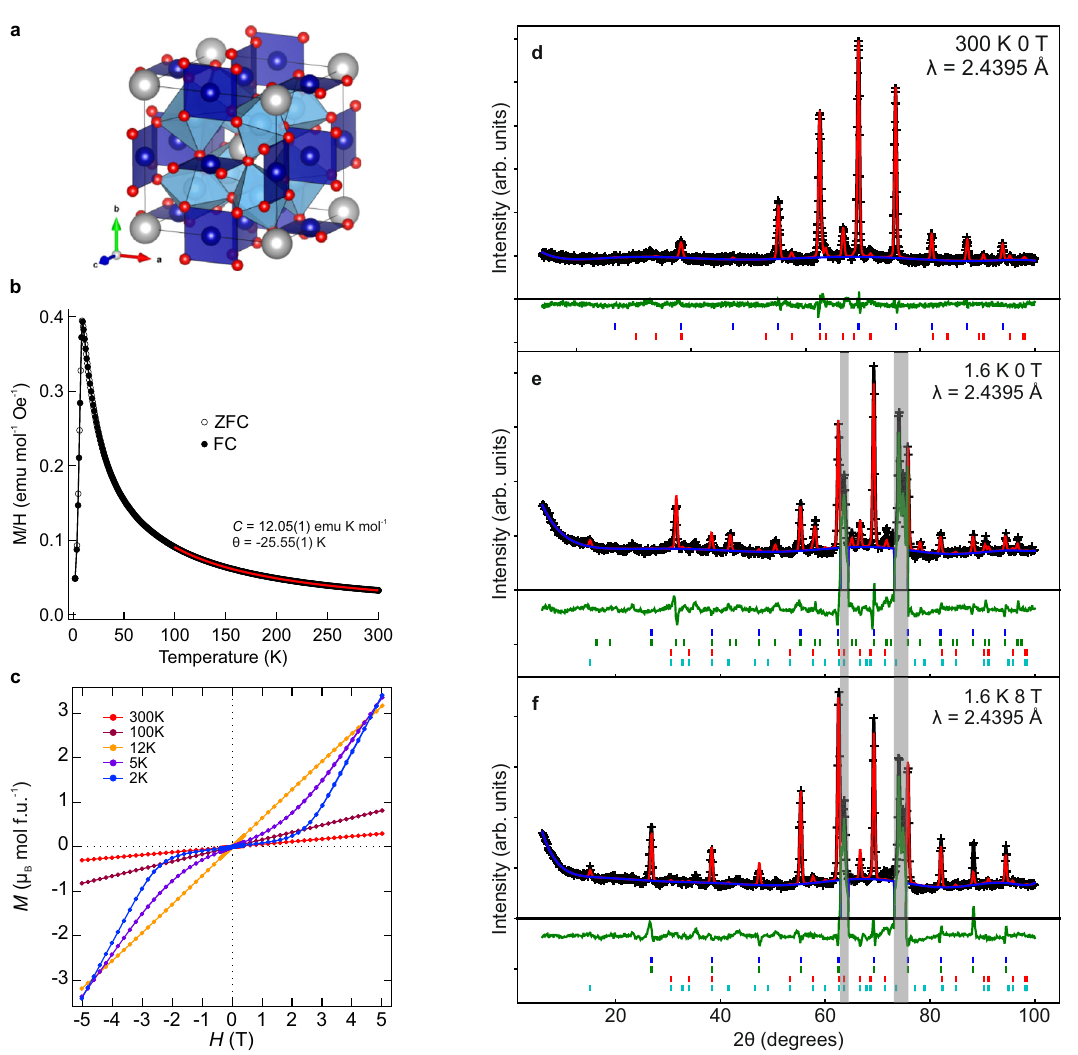
Fig. 1 Crystal structure and experimental data collected from CaCo 3 Ti 4 O 12 . a Quadruple perovskite crystal structure. b Zero- fi eld (ZFC) and fi eld cooled (FC) magnetization data collected as a function of temperature from CaCo 3 Ti 4 O 12 under an applied fi eld of 1 T. c Magnetization data collected as a function of fi eld from CaCo 3 Ti 4 O 12 . Observed (black), calculated (red), and difference (green) plots from the re fi nement of CaCo 3 Ti 4 O 12 against neutron powder diffraction data collected at d 300 K, e 1.6 K under 0 T, and f 1.6 K under 8 T. In d the upper set of tick marks corresponds to contributions from CaCo 3 Ti 4 O 12 and the lower set to contributions from the CoTiO 3 secondary phase. In e and f from top to bottom the tick marks correspond to: CaCo 3 Ti 4 O 12 nuclear and magnetic re fl ections and CoTiO 3 nuclear and magnetic re fl ections. The shaded regions correspond to contributions from the cryomagnet which were excluded from the re fi